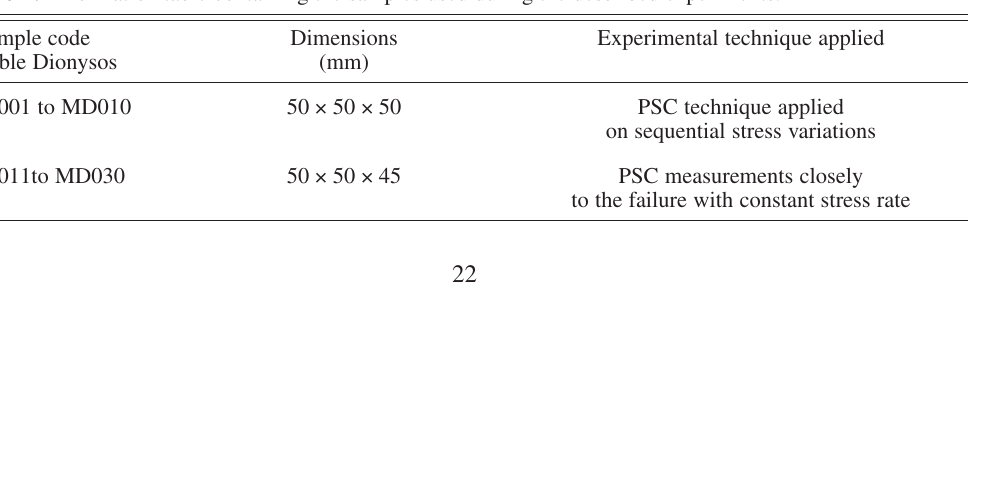
Table I. Information table containing the samples used during the described